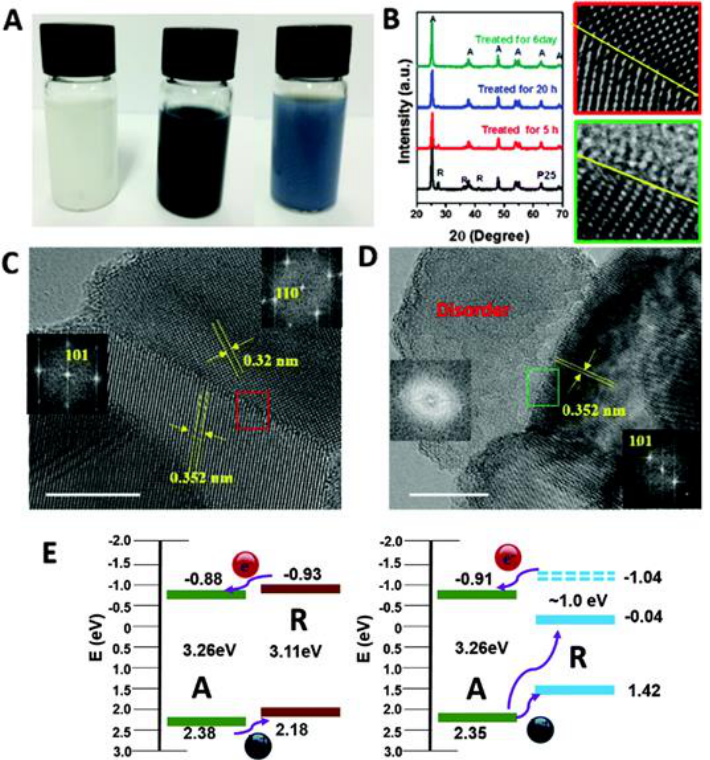
Figure 3. ( A ) Photographs of P25 (left), disordered anatase–TiO 2 (middle) and disordered rutile TiO 2 (right) suspensions (0.05 g L −1 ) after Li– Ethylene diamine (EDA) treatment for 6 days; ( B ) x-ray diffraction (XRD) patterns of the Li–EDA-treated P-25 crystals with different treatment times for the (A) anatase phase and the (R) rutile phase. ( C ) HR-TEM images and selected area electron diffraction pattern of P-25; scale bar: 10 nm; ( D ) HR-TEM images and the selected-area electron diffraction pattern of blue P-25; scale bar: 10 nm. Enlarged TEM images of the junction area (red squares: P-25 and green squares: blue P-25); ( E ) calculated bandgap diagrams of P25 (left) and blue P-25 (right). Reproduced from [1]. Copyright (2016), The Royal Society of Chemistry.